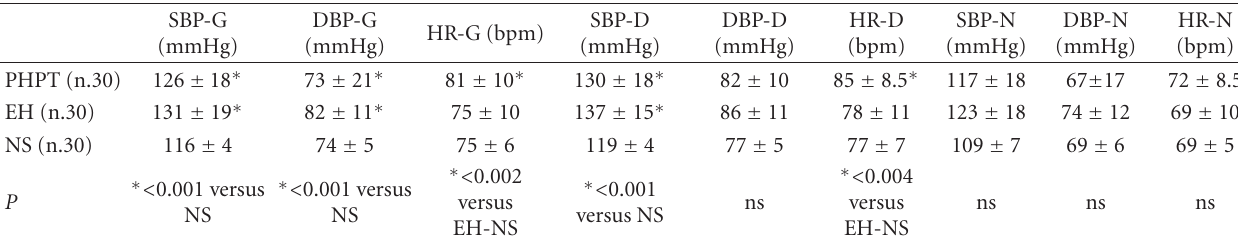
Table 2: Ambulatory blood pressure monitoring (ABPM) during 24 hours in studied